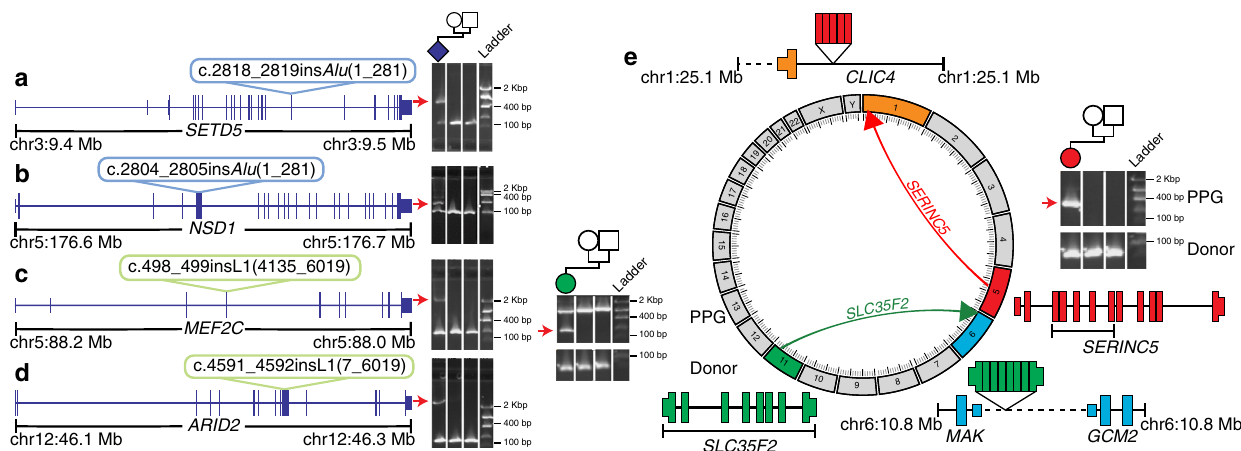
Fig. 3 RT-derived de novos in the DDD. We identi fi ed a total of nine de novo MEIs, four of which disrupted the protein-coding sequence of a known DD gene: a SETD5 , b NSD1 , c MEF2C , and d ARID2 . Shown in each panel is a diagram of the affected gene (blue model) with the relevant insertion indicated with a colored bubble. To the right are PCR validations con fi rming the de novo status of each mutation; a positive result is indicated by a raised secondary band present only in the proband sample (red arrow). e Circos diagram and PCR results for two identi fi ed germ-line de novo PPGs. For each de novo PPG shown is a diagram of the donor gene (gene model), location of duplication as PPG (directional arrow), and new insertion site. Exons from the donor gene included in the PPG are indicated by brackets underneath the donor gene model. To con fi rm PPG presence, PCR was performed (Methods) on proband, paternal, and maternal gDNA (sample in each lane is shown by pedigree). The band which represents the PPG is marked with a red arrow, and was con fi rmed via capillary sequencing (Supplementary Fig. 12). Dashed lines indicate intergenic regions, all genes models are shown in sense orientation, and PPG gene diagrams are not to scale